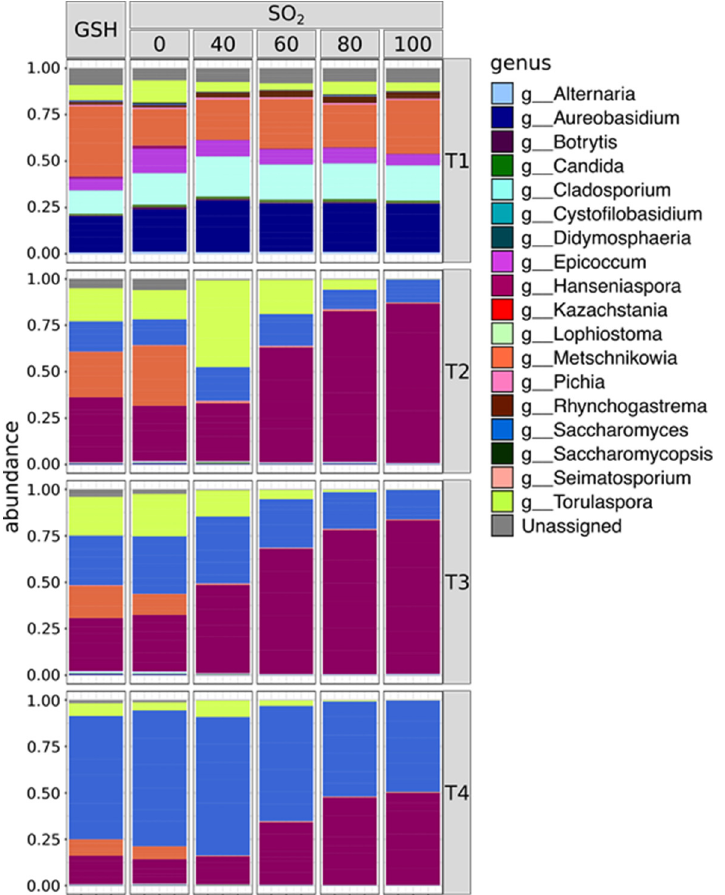
Figure 1. Genus-level metabarcoding analysis of community response to SO 2 addition. Vintage 2018 Chardonnay juice was treated with increasing concentrations of total SO 2 (mg/L) or glutathione (GSH, 250 mg/L) as an alternate antioxidant. Ferment samples were taken at four timepoints (T1, at crush; T2, 10% sugar utilization; T3, 50% sugar utilization; T4, 90% sugar utilization) and subjected to ITS metabarcoding. Only genera that exceeded 0.1% abundance in at least one sample are shown.